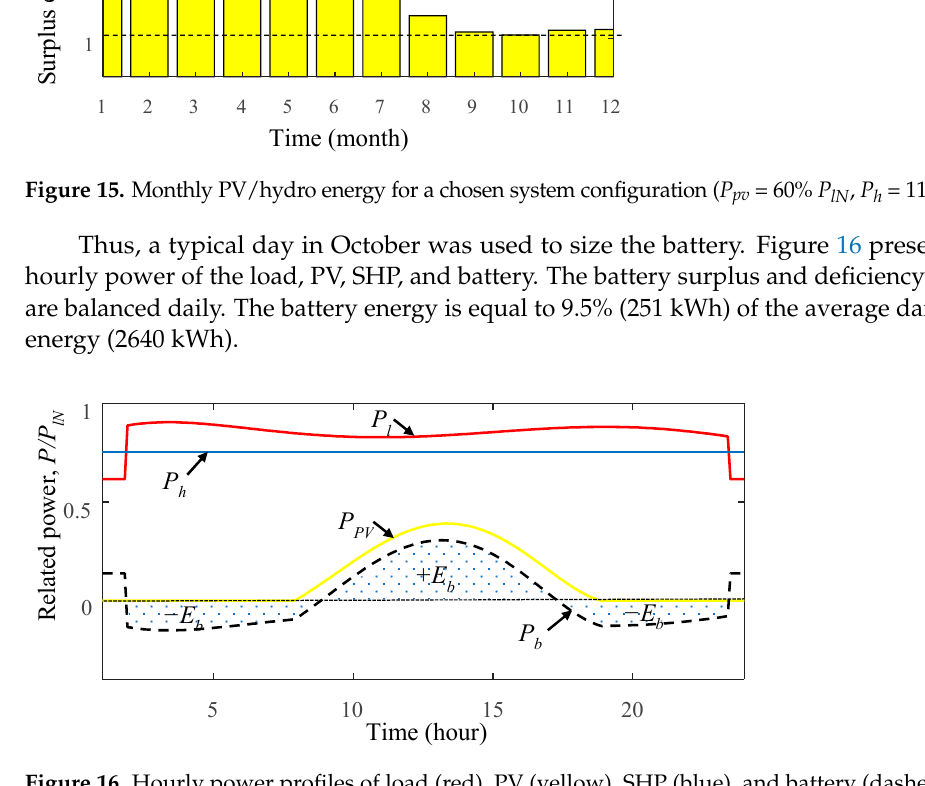
Figure 16. Hourly power profiles of load (red), PV (yellow), SHP (blue), and battery (dashed black) related to nominal load power.